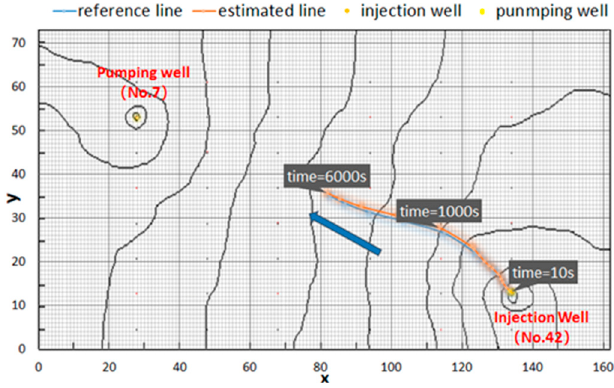
Figure 7. Transport route of the tracer center. The units of axis are cm.